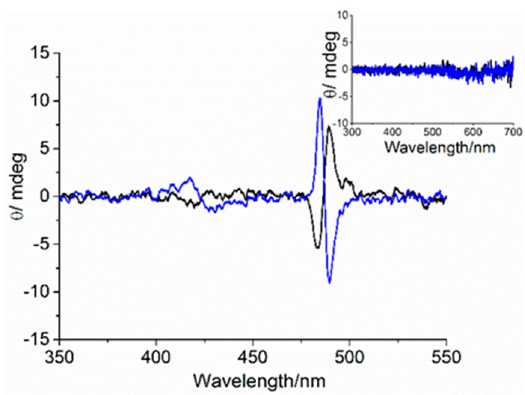
Figure 5. CD spectra of TPPS@AuNP co-deposit for d -( black line ) and l -( blue line ) histidine samples. The inset shows the corresponding AuNP deposit grown from d -( black line ) and l -(b lue line ) histidine. Raman and SERS